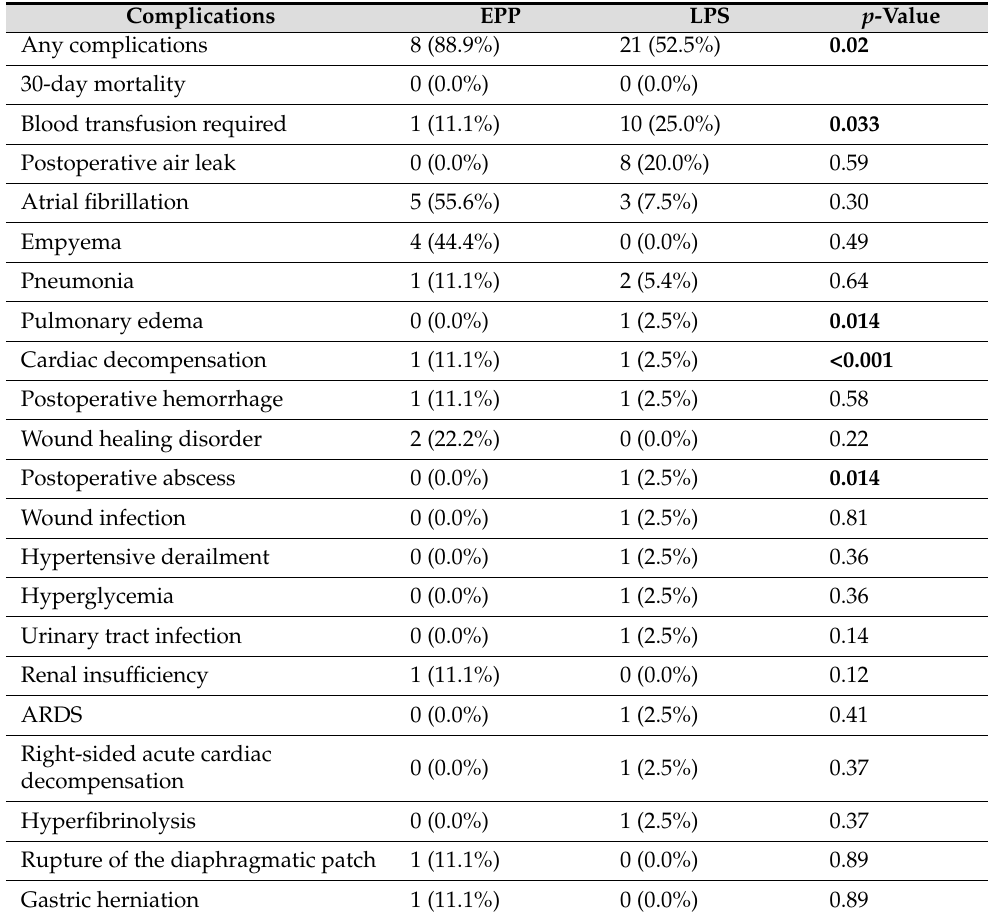
Table 3. Postoperative complications in the whole cohort. The p -values and hazard ratios were determined by univariate Cox regression. ARDS acute respiratory distress syndrome, statistically significant p -values were printed in